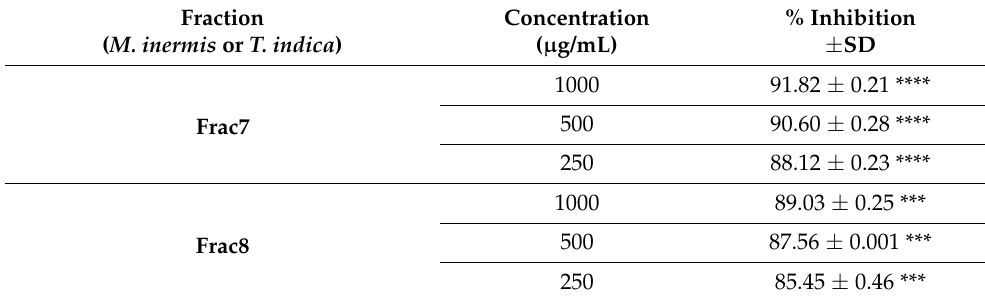
Table 1. Cont. Fraction ( M. inermis or T. indica ) Frac7 Frac8